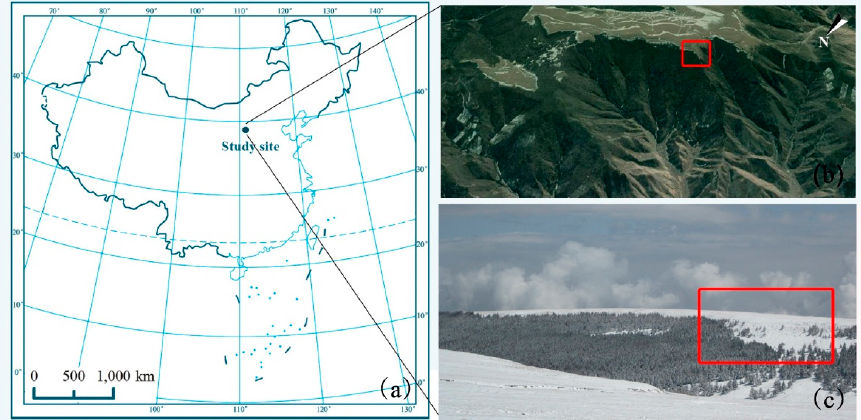
Figure 1. ( a ) Location of the study area in North-Central China; the study area landscape in summer ( b ) and winter ( c ).